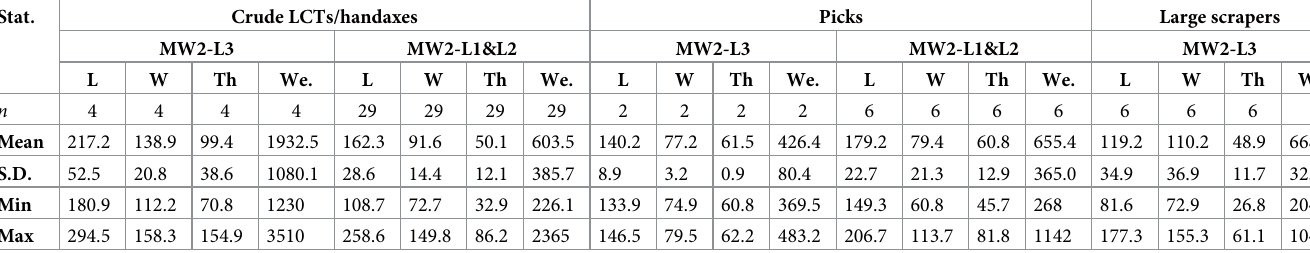
Table 9. Descriptive statistics of dimensions of LCTs in MW2 assemblages.